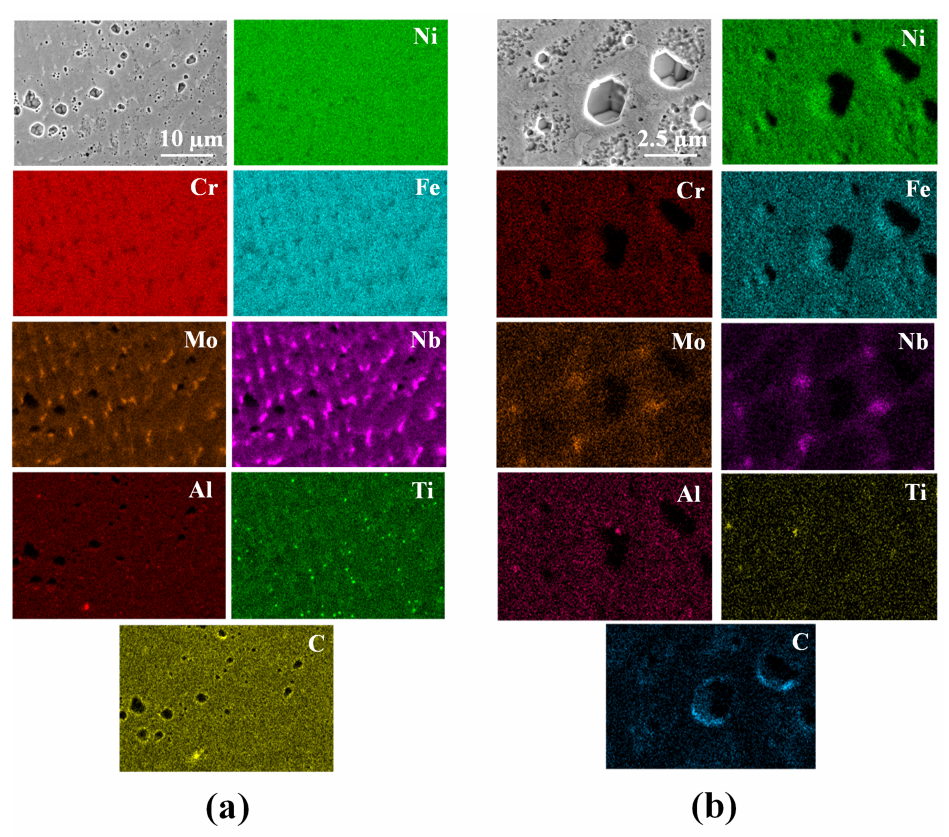
Figure 11. EDS map of a deposit region near the ( a ) bottom and ( b ) top of the powder-fed L-DED specimen highlighting the secondary